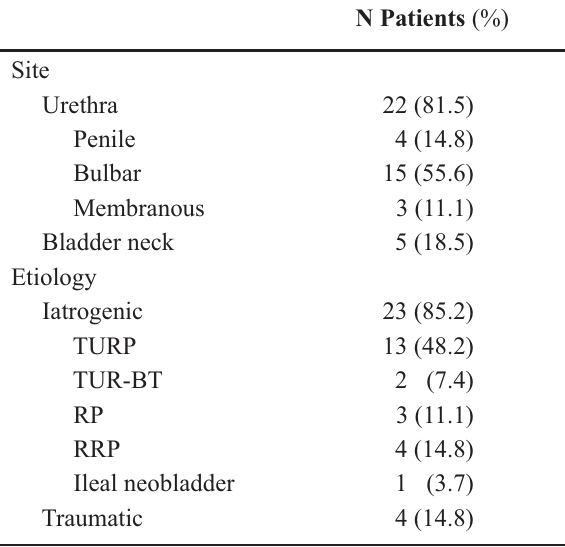
Table 1 – Site and etiology of the stricture.